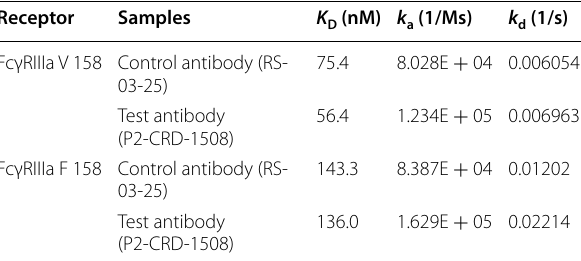
Table 5 SPR kinetic values obtained for FcγRIIIa V158 (A and B) and F158 (C and D) receptors for the test anti-CD20 antibody and control